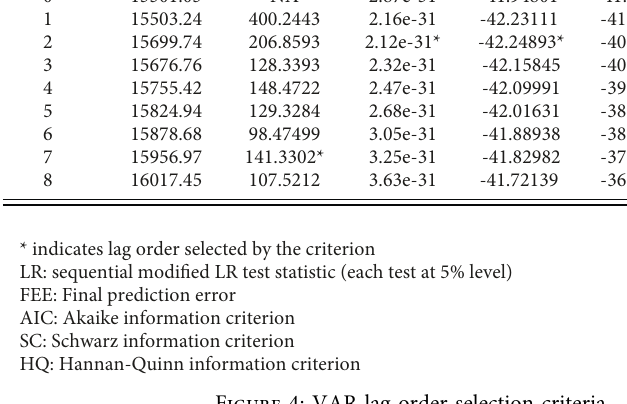
Figure 4: VAR lag order selection